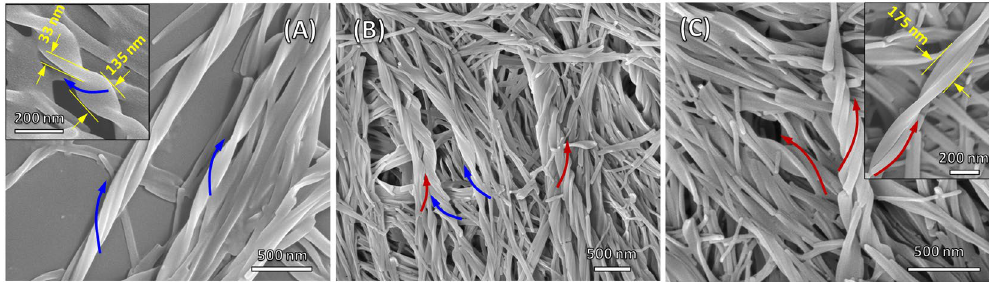
Figure 6. SEM microscopy employed to visualise helical pH dependent self-assembly. SEM micrographs of the helical supramolecular microstructures of NDI-L-Glu (1) produced by solvent evaporation at pH ( A ) 3.0 (left handed twisted ribbons), ( B ) 7.0 (a mixture of left and right handed twisted ribbons), and ( C ) 9.0 (right handed twisted